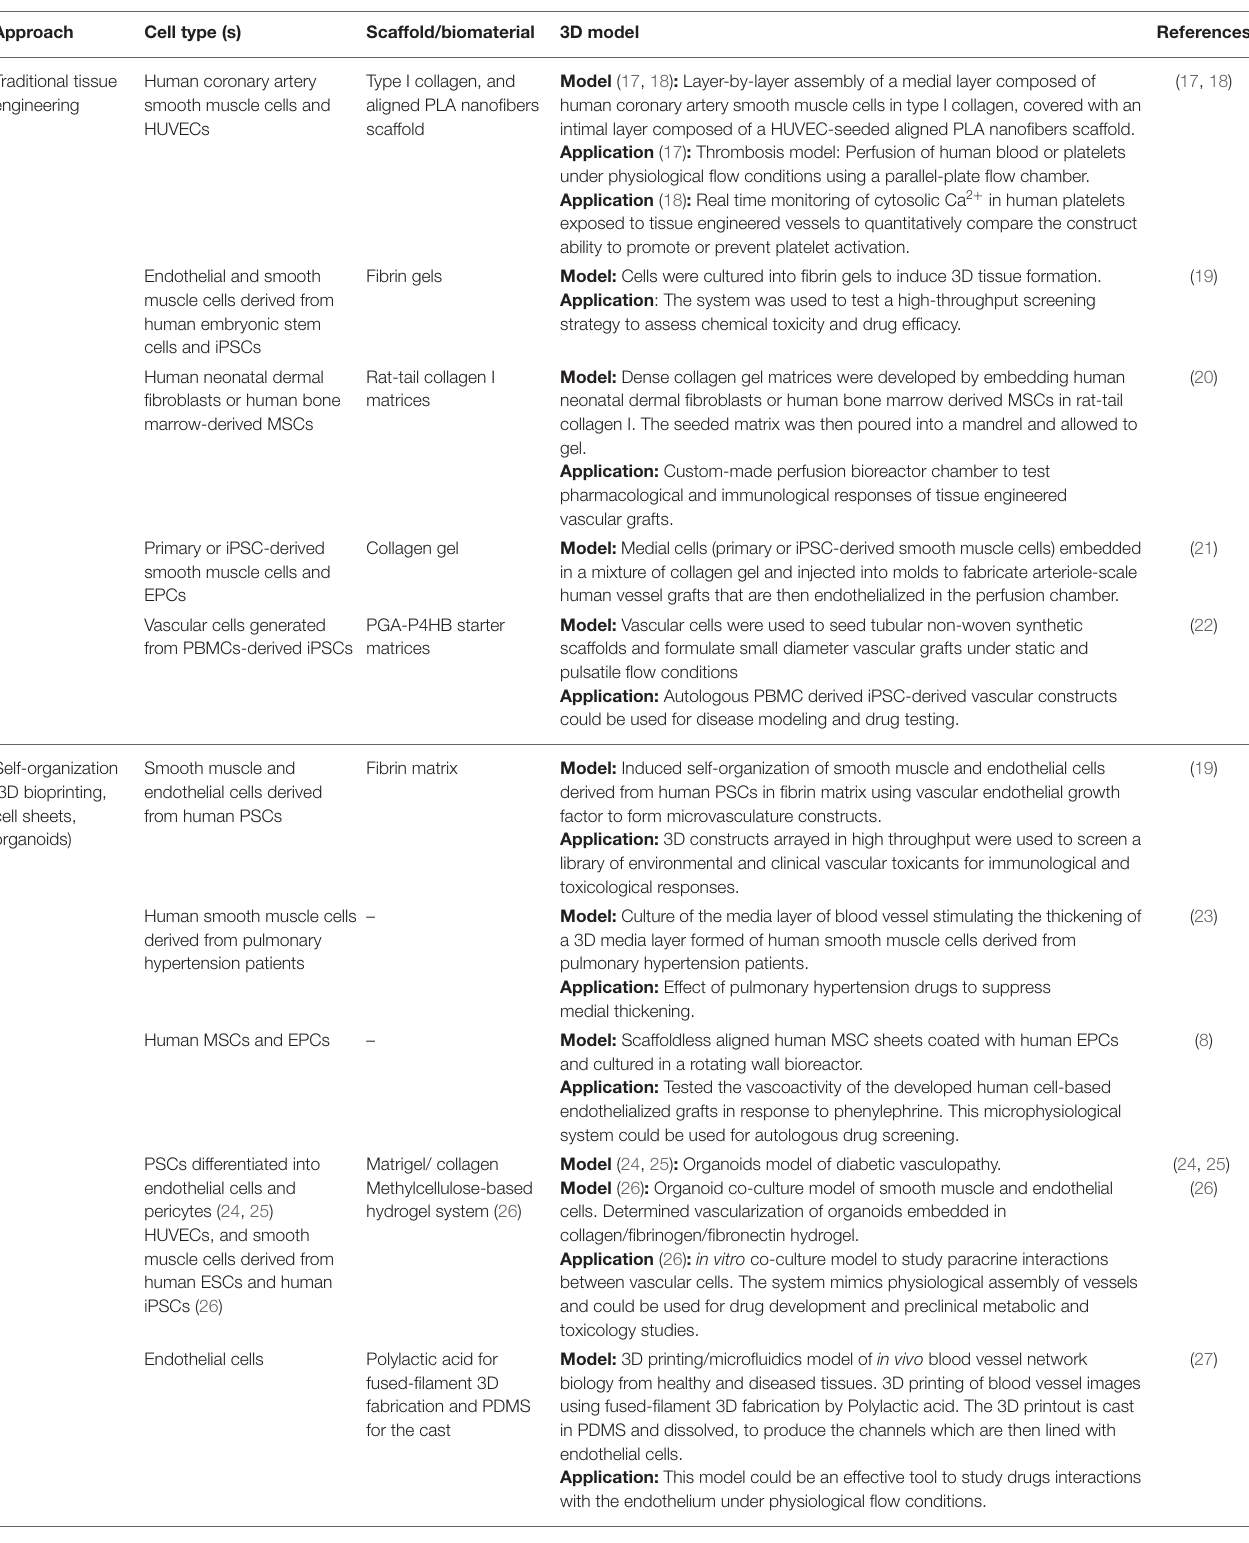
TABLE 2 | Examples of 3D vascular drug screening models developed using different tissue engineering approaches including traditional tissue engineering, self-organization (3D bioprinting, cell sheets, and organoids), and self- assembly.